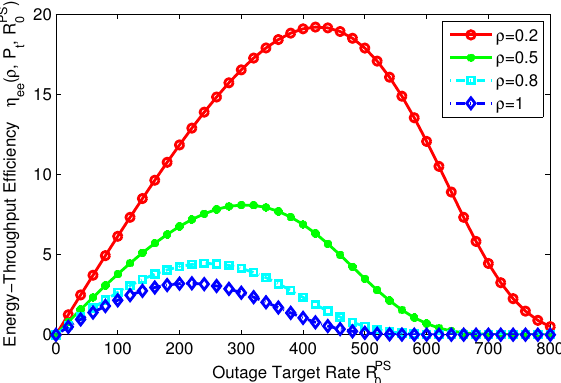
Figure 18. Energy-throughput efficiency versus outage target rate with different power splitting ratio for PS